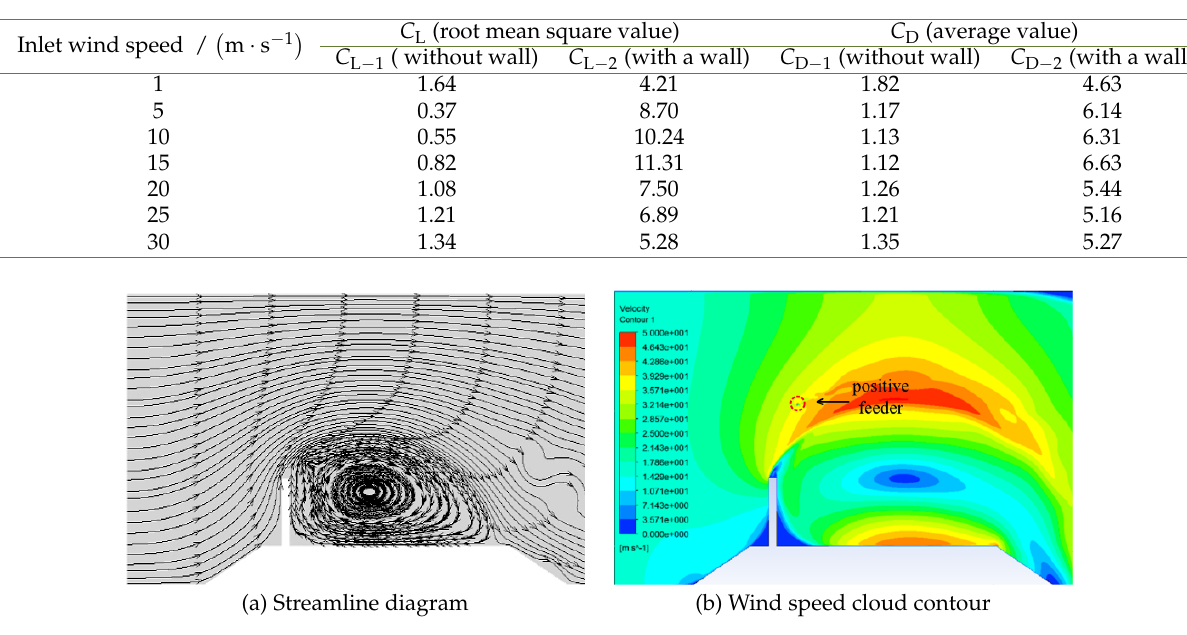
Fig. 8. Flow field diagram of calculation domain with single wind-break wall